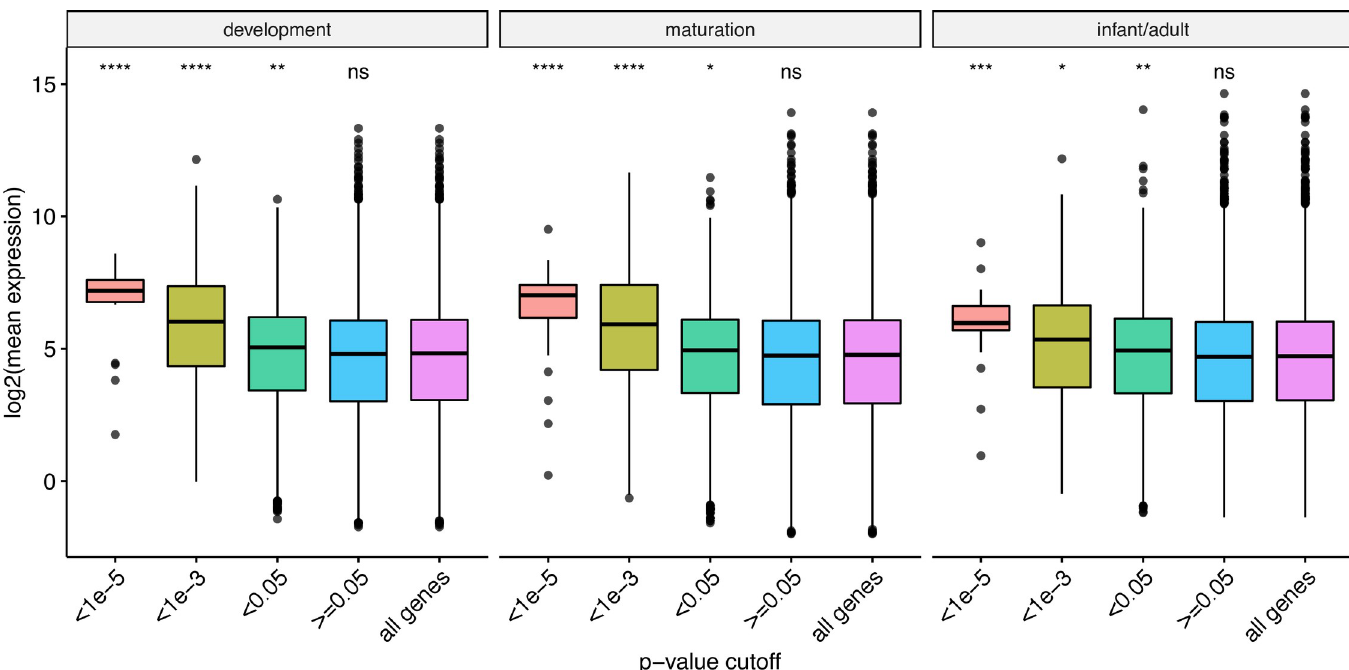
Fig 5. Comparison of the mean expression (heart) distribution at different metaP cut-offs. Panels show three different heart development stages: early development, maturation and infant/adult. X-axis denotes the combined p-value from DNV and CNV analysis ( metaP , at different cut-offs). Y-axis denotes the genes’ mean expression in the heart (log scale). The 21 significant candidate CHD genes ( Table 1 ) are contained in the fraction with the higher expression (red box). Differences between the distributions were tested using a two-sided Wilcoxon rank sum test (reference group: all genes). ���� : P < 0.0001, ��� : P < 0.001, �� : P < 0.01, � : P < 0.05, ns: non-significant.